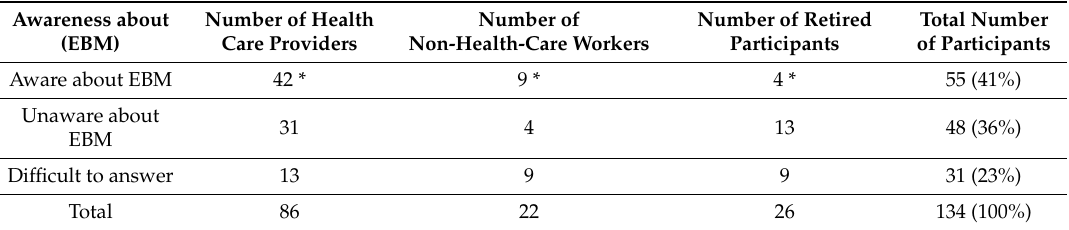
Table 9. Participants’ awareness of evidence-based medicine